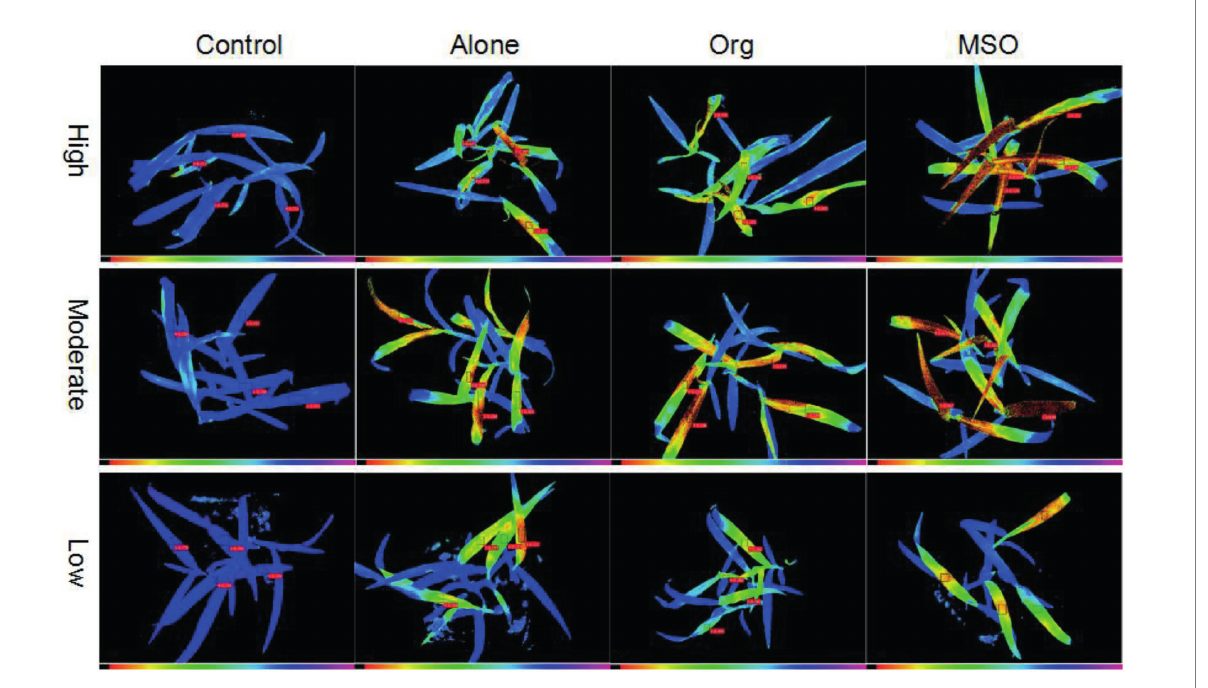
FIGURE 1 Chlorophyll fluorescence images of giant foxtail at 5 days after treatment. The topramezone dose was 6.3 g a.i. ha − 1 ; control means treated with tap water; Alone means topramezone was applied alone; Org means topramezone was applied with a tank-mix of organosilicone; MSO means topramezone was applied with a tank-mix of